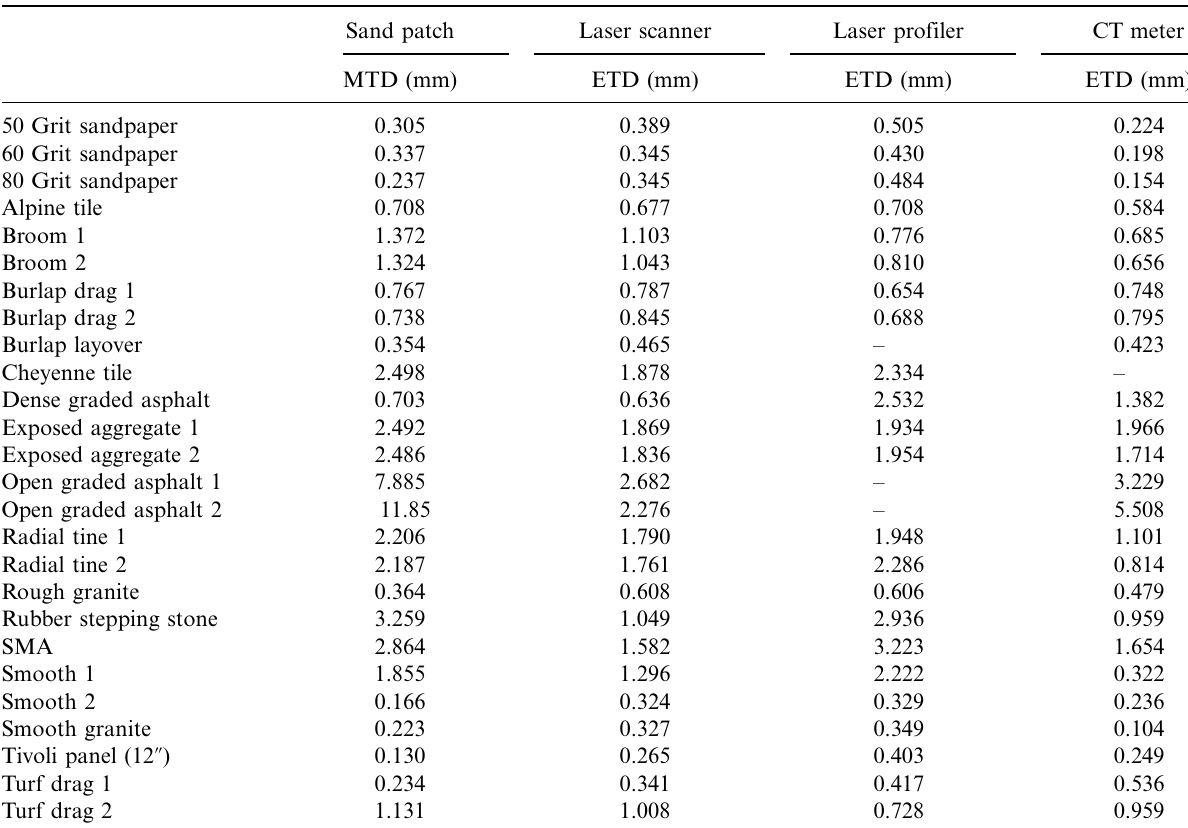
Table 1. Average MTD from sand patch tests compared with average ETD for laser texture scanner, Dynatest laser profiler at 25 mph speed, and CT